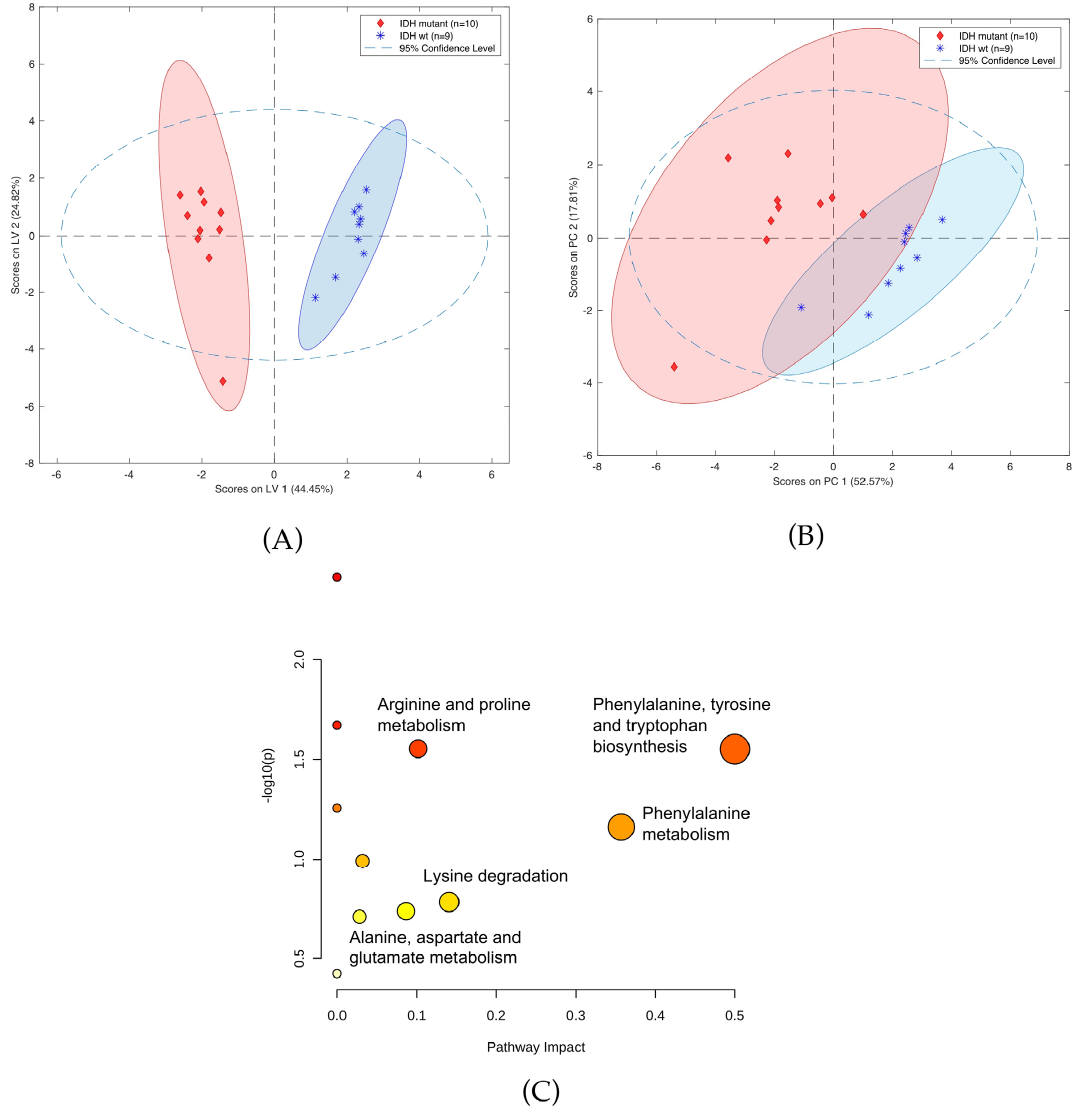
Figure 6. ( A ) OPLS-DA two-class model ( B ) and PCA plot of LC-MS data from patients with (blue circles) and without IDH mutation (green squares). ( C ) Pathway analysis of metabolites present in patients due to IDH mutation.